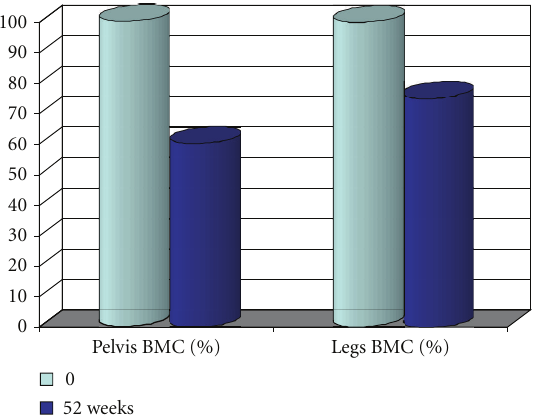
Figure 2: Disuse produces a dramatic bone loss in paraplegic patients, more so in trabecular rich bone areas (pelvis) than in areas containing relatively more cortical bone (femurs and tibias) (redrawn from Wilmet et al.